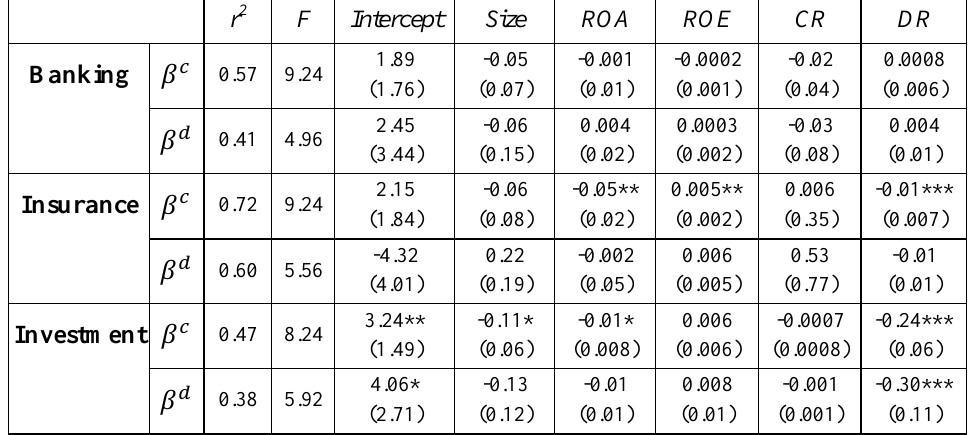
Table 5: Effect of firm characteristics on jump beta and continuous beta